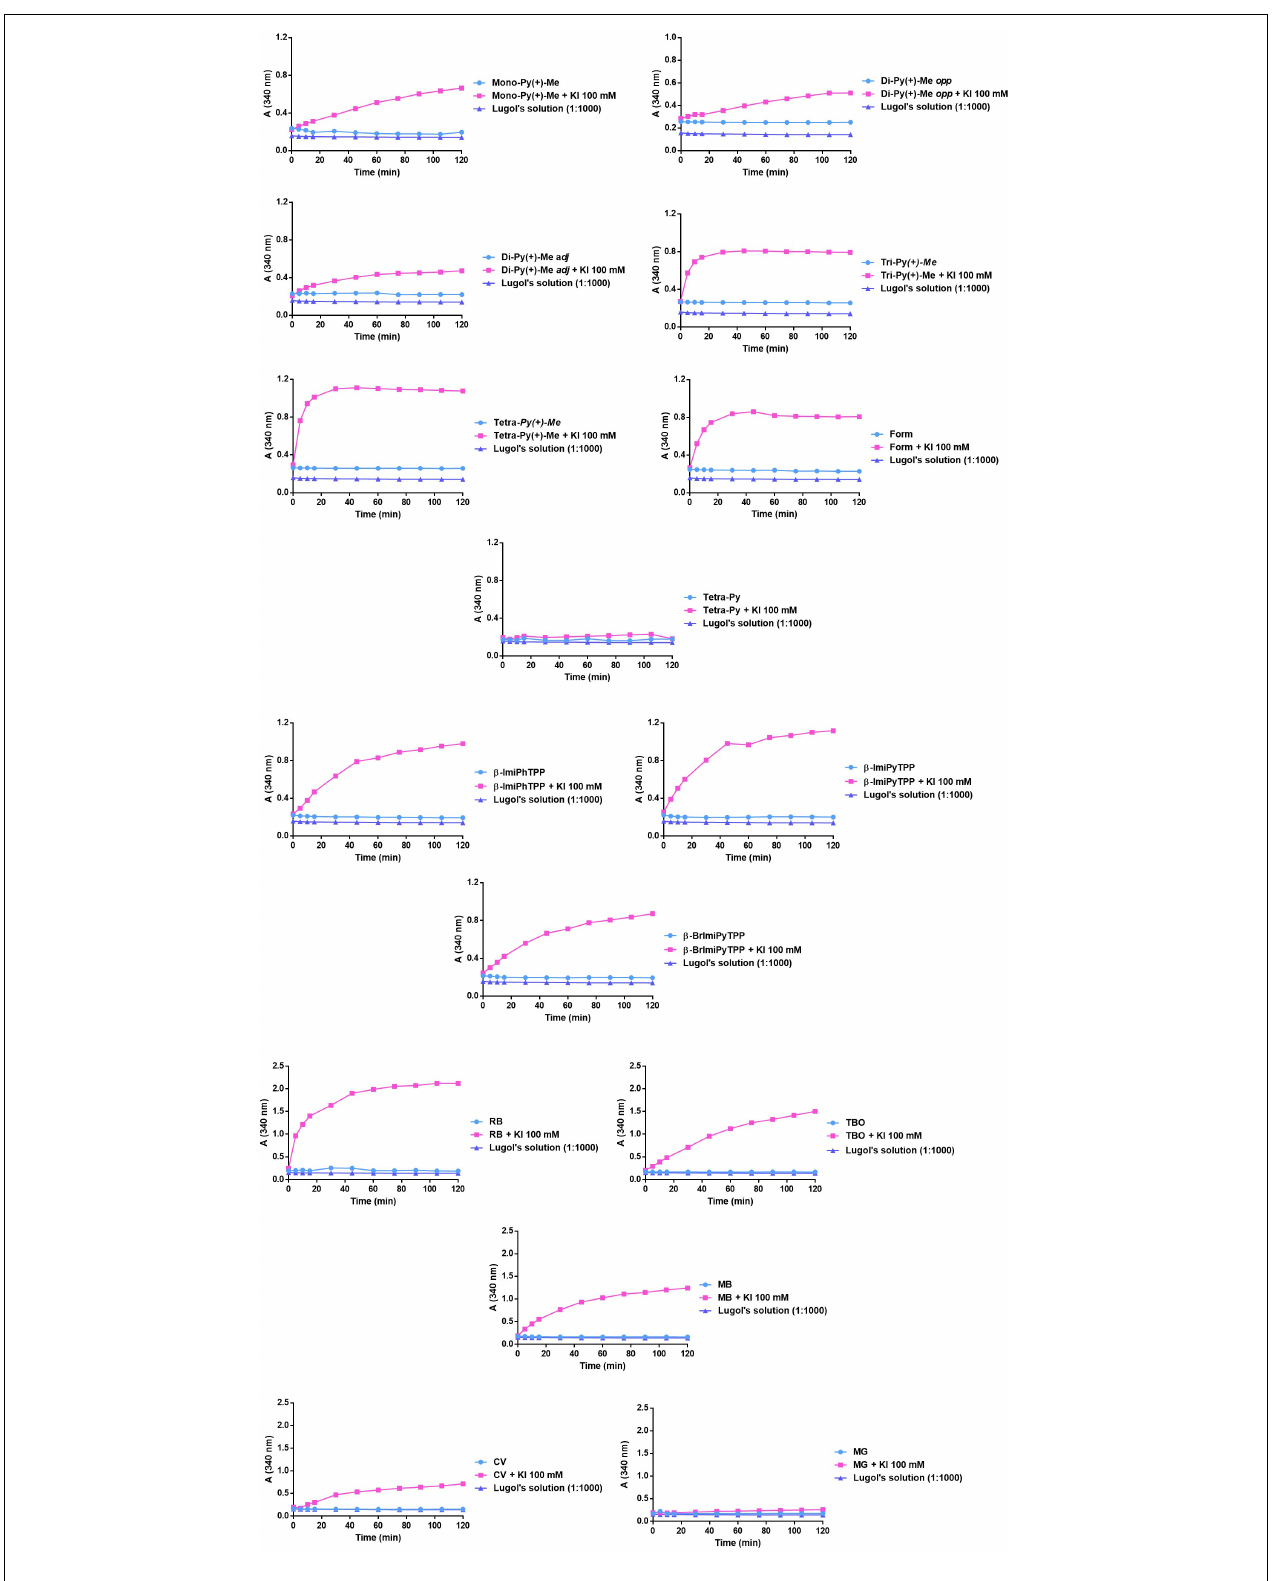
FIGURE 7 | Monitoring of the formation of iodine at 340 nm after different irradiation periods in the presence of each PS at 5.0 µ M and combinations of each PS at 5.0 µ M and KI at 100 mM.